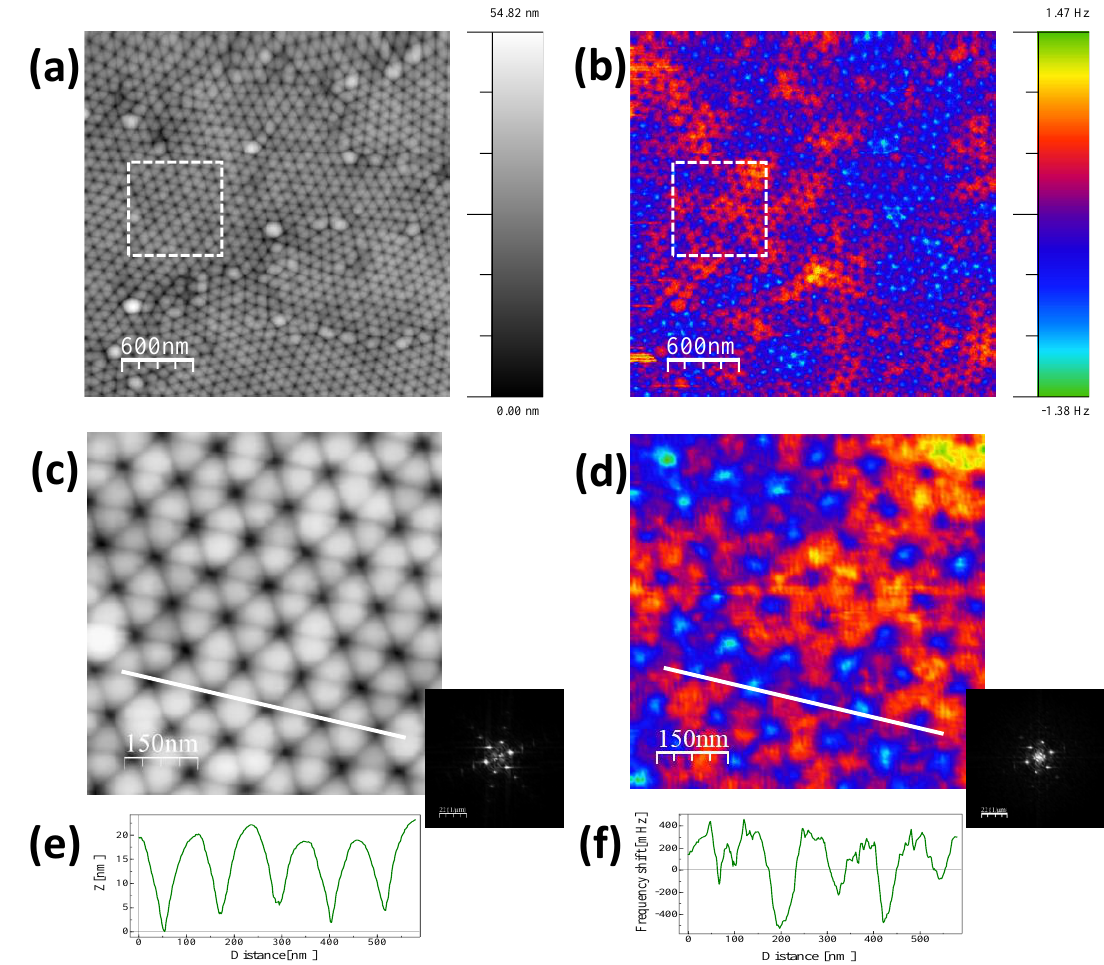
Figure 3. ( a ) Topography and ( b ) Magnetic Force Microscopy (MFM) images corresponding to the Dy 13 Fe 87 antidot sample with 30 nm in thickness; ( c , d ) are zooms corresponding to the marked region in ( a , b ), respectively. Insets correspond to the FFT of each image; ( e , f ) are the profiles obtained along the marked lines in ( c , d ). The magnetic state of the sample is as prepared .